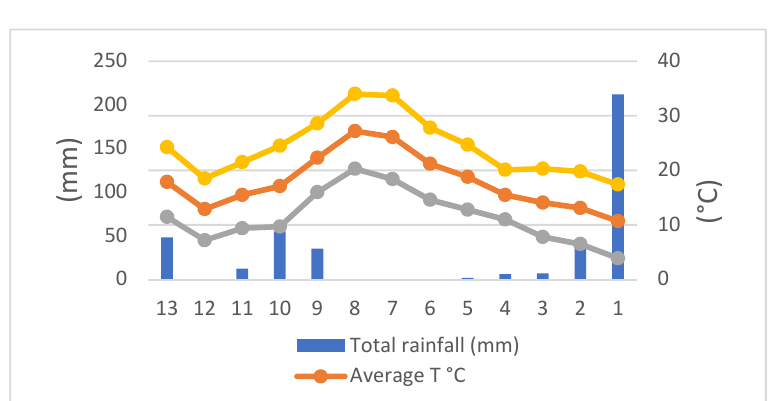
Figure A1. Climate parameters for the Berkane site (2020).